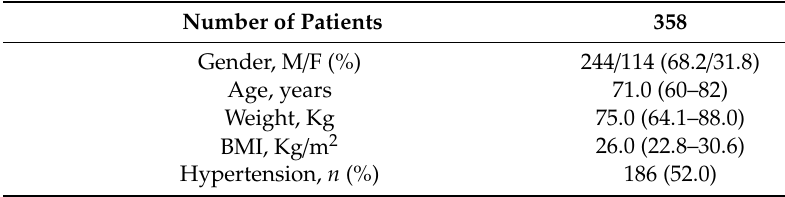
Table 1. Characteristics of the population. Results are presented as median (IQR) and absolute value (percentage). The results are presented as median (IQR) for continuous variables and number (%) for categorical variables.